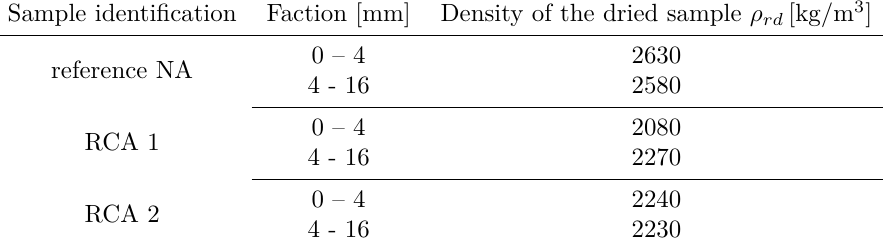
Table 3. Determination of bulk density in the dried state.